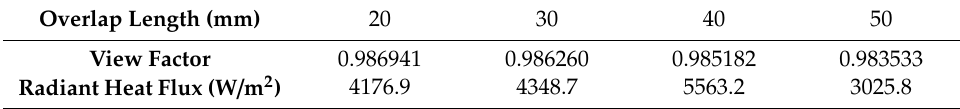
Table 7. View factor and radiative heat flux from the flame to the preheating zone. Overlap Length